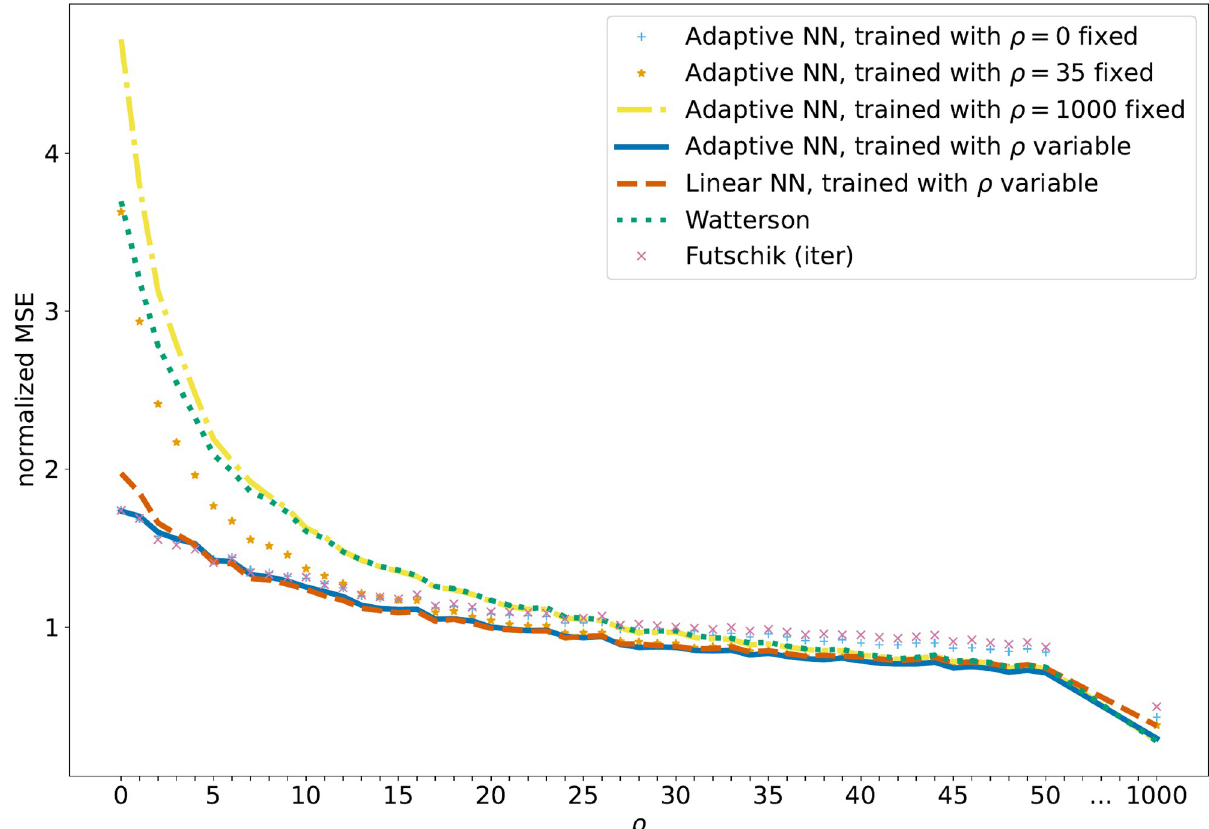
Fig 2. MSE for variable recombination rates. The normalized MSE of feedforward neural network estimators of the mutation rate compared to model-based estimators. In particular, the adaptive networks trained with a fixed recombination rate are compared to the networks trained with variable recombination rates. The recombination rate is given by ρ = 0, ... , 50 or ρ = 1000, while the sample size n = 40 and mutation rate θ = 40 are fixed. MSE estimates are based on 10 5 independently simulated SFS for each value of ρ